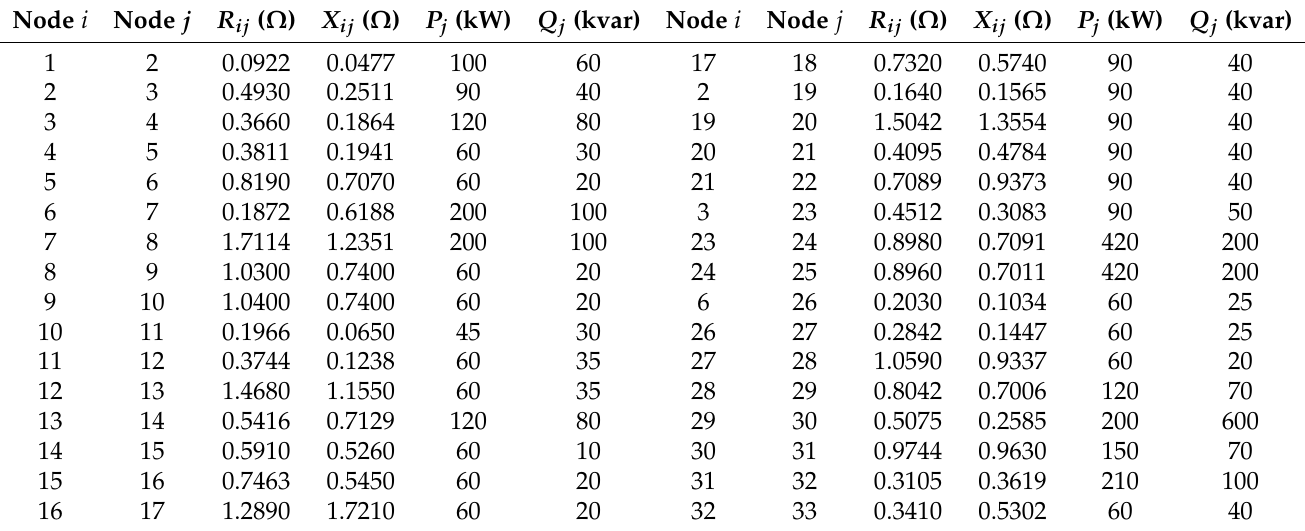
The shaded areas in Figure 3 represent the types of consumer connected to the distri- bution grid, i.e., industrial, commercial, and residential loads. Each of the per-unit demand curves are depicted in Figure